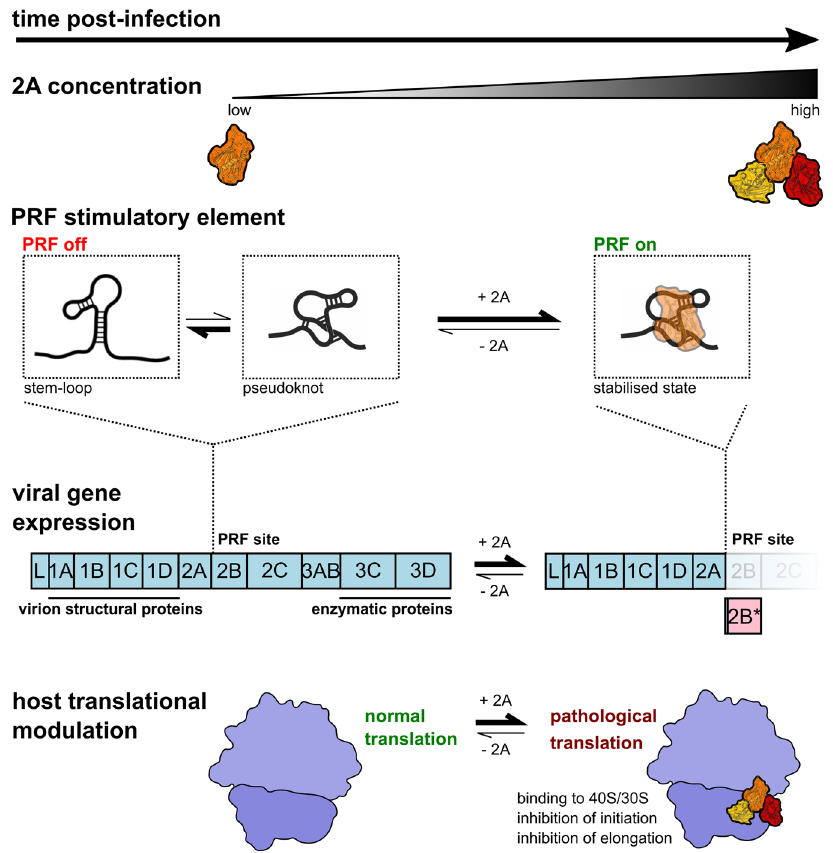
Fig. 8 Molecular basis for 2A-induced reprogramming of gene expression. The PRF stimulatory RNA element is predicted to form either stem-loop or pseudoknot conformations. As 2A accumulates during EMCV infection, it selectively binds to and stabilises a pseudoknot-like conformation of the PRF stimulatory element, thereby enabling PRF, producing trans- frame product 2B* and downregulating the expression of enzymatic viral proteins later in infection. 2A also binds directly to the small ribosomal subunit at the translational GTPase factor binding site, progressively inhibiting both initiation and elongation as it accumulates. This may contribute to the shutdown of host cell translation during lytic